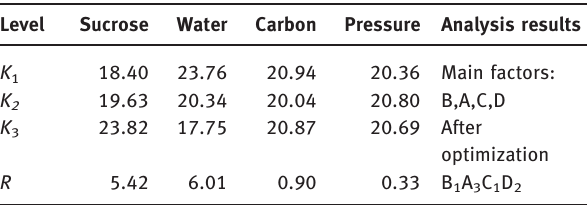
Table 3: Range analysis results for SSD briquetting process.